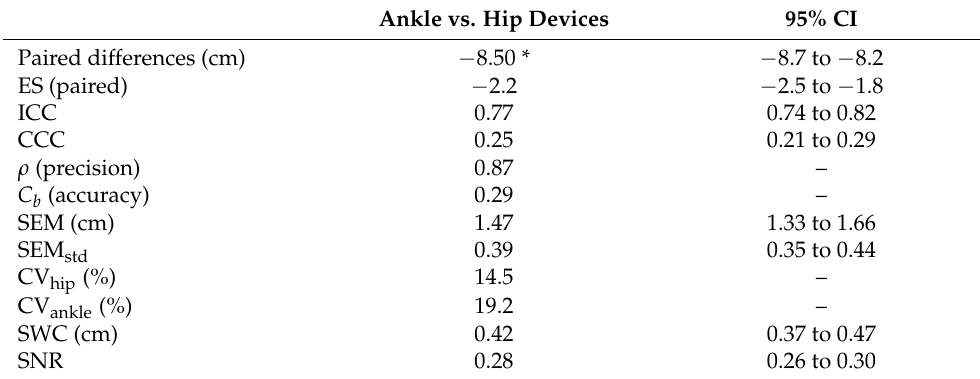
Table 4. Between device reliability for the Vmaxpro inertial measurement unit. Ankle vs. Hip Devices